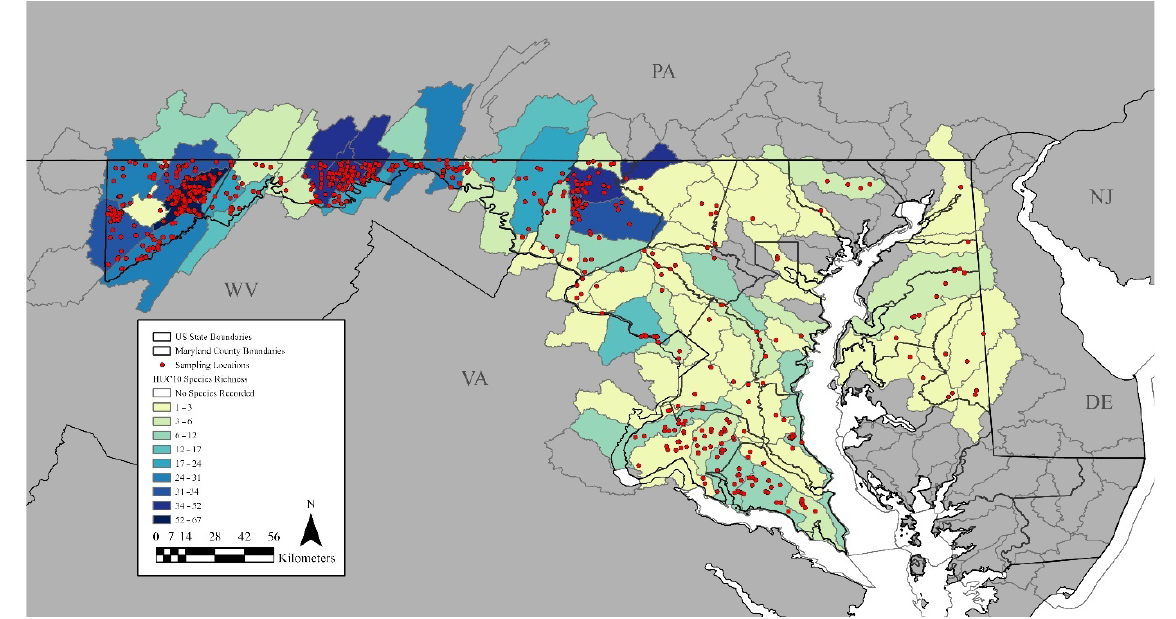
Figure 2. Species richness for United States Geological Survey Hydrologic Unit Code (HUC)-10 catchments of Maryland with georeferenced collection locations. Table 2. Updated checklist of Maryland stoneflies. New state records species are indicated with an asterisk